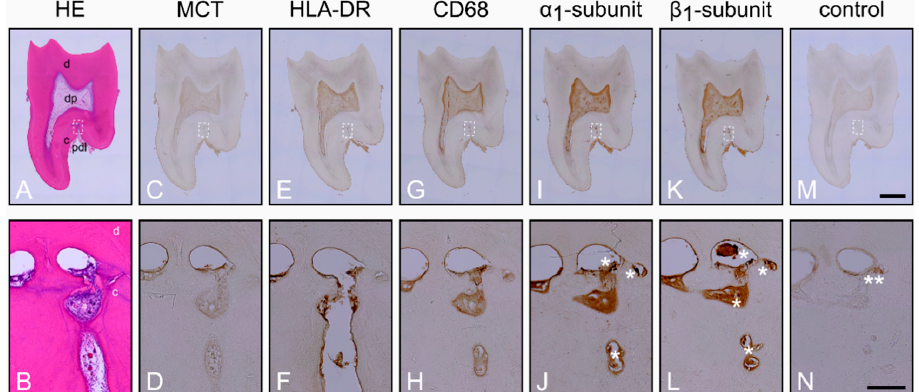
Figure 1. Histological characterization of the healthy periodontium and localization of the α 1 - and β 1 -subunits of guanylyl cyclase (sGC) in cementoclasts: consecutive sections of a representative molar with adherent clinically healthy periodontium were stained with Hematoxylin and Eosin (HE) ( A , B ) and incubated with antibodies for Mast Cell Tryptase (MCT) ( C , D ), Human Leukocyte Antigen-DR isotype (HLA-DR) ( E , F ), CD68 ( G , H ), α 1 -subunit ( I , J ), and β 1 -subunit ( K , L ), respectively. Incubation of sections without primary antibodies served as control ( M , N ). The images of the upper row show an overview of the consecutive sections, while the detail images of the lower row show the regions represented by the rectangle in the overview images of the upper row. d = dentin, dp = dental pulp, c = cementum, pdl = periodontal ligament. Asterisks in ( J ) and ( L ) shown cementoclasts in resorption lacunae, while asterisks in ( N ) only show an artifact. Scale bar = 2 mm ( M ) and = 200 µm ( N ).